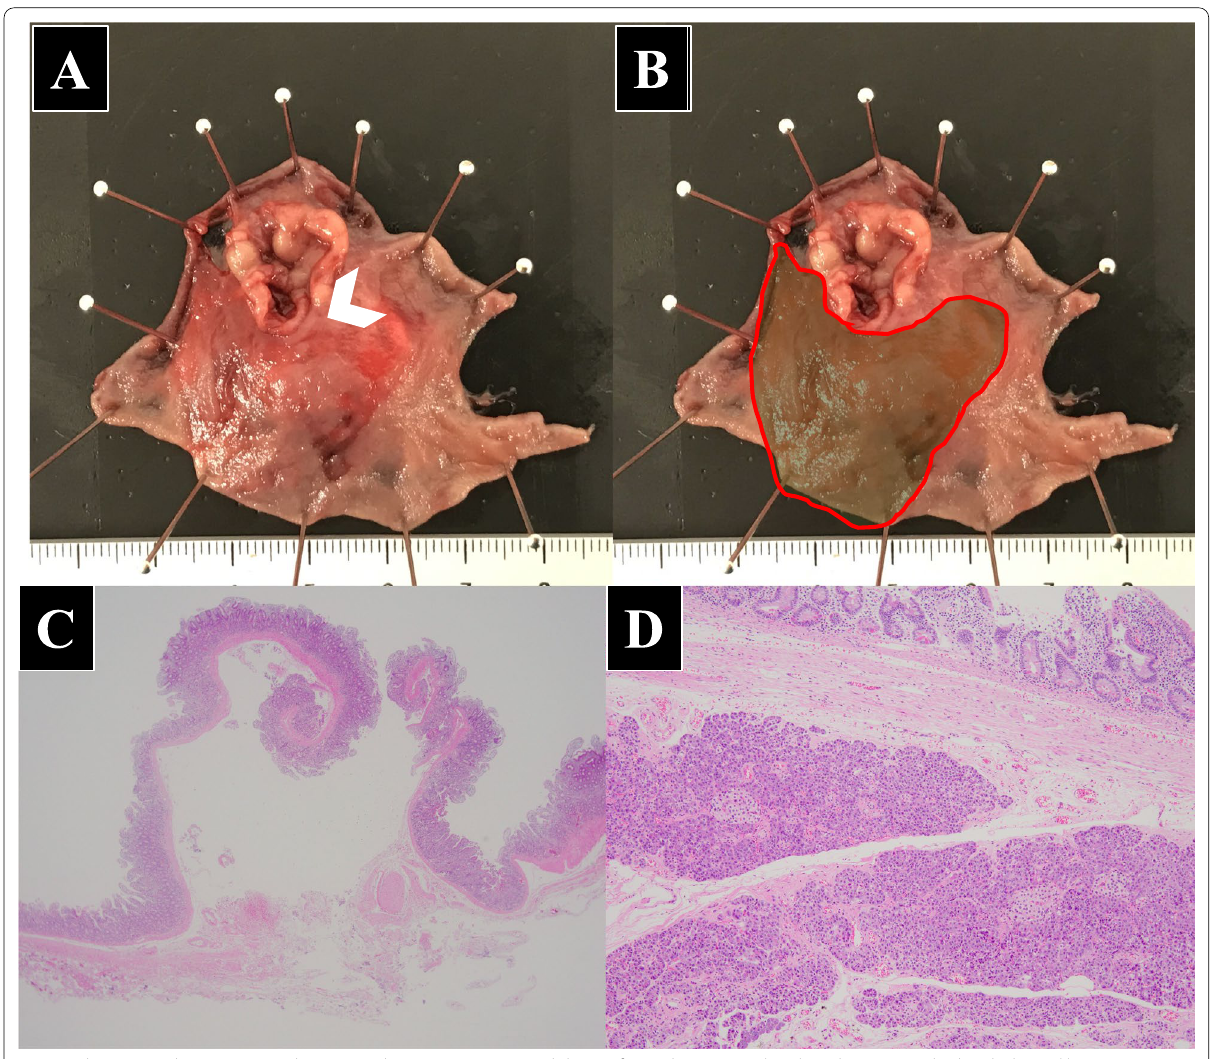
Fig. 3 The resected specimen. A The resected specimen contained the perforated site ( arrowhead ). B The area marked with the red line was covered by HP in the submucosa. The surgical margin was positive for HP. C The microscopic view of the specimen indicated that the perforated mucosa was not covered by HP (hematoxylin and eosin 50). D Additionally, it revealed the presence of normal, well-recognized pancreatic tissue, × including islets of Langerhans, in the surrounding areas (hematoxylin and eosin ×